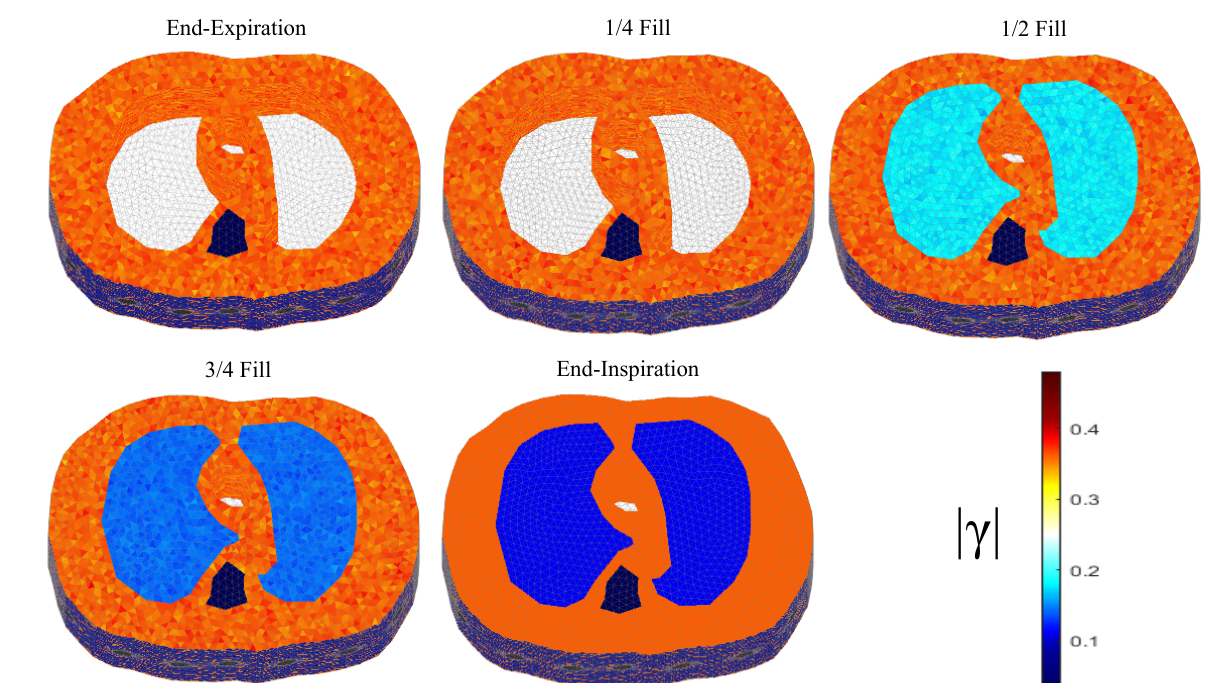
Figure 3. The 3D structure for the 2nd subject case in 5 breath cycle states.